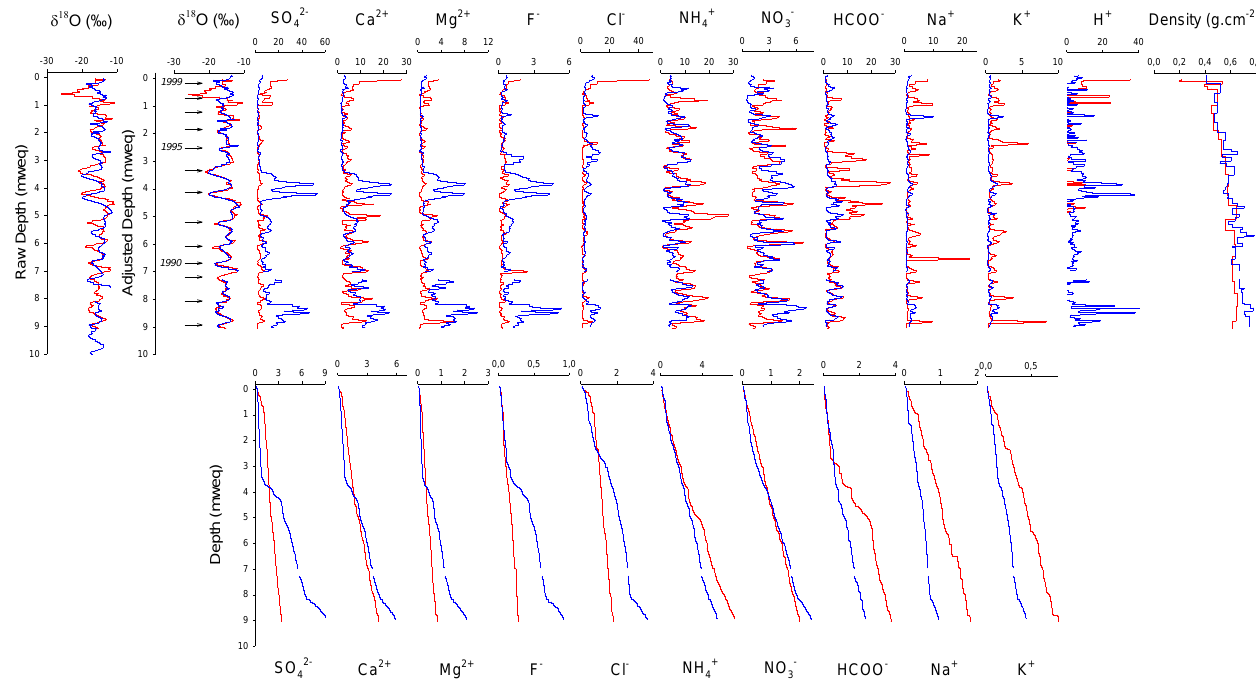
Fig. 2. (a) Comparison of δ 18 O, major ion concentration and density profiles recorded in core A (1999, red line) and B (2000, blue line). Ion Figure 2 concentrations are in µEqL − 1 . (b) Cumulated deposition fluxes of the different ions (in mgcm − 2 ). The depth scale of core B is adjusted to that of core A by matching of the δ 18 O records. The arrow indicates the limit of some contiguous bimodal shape years.